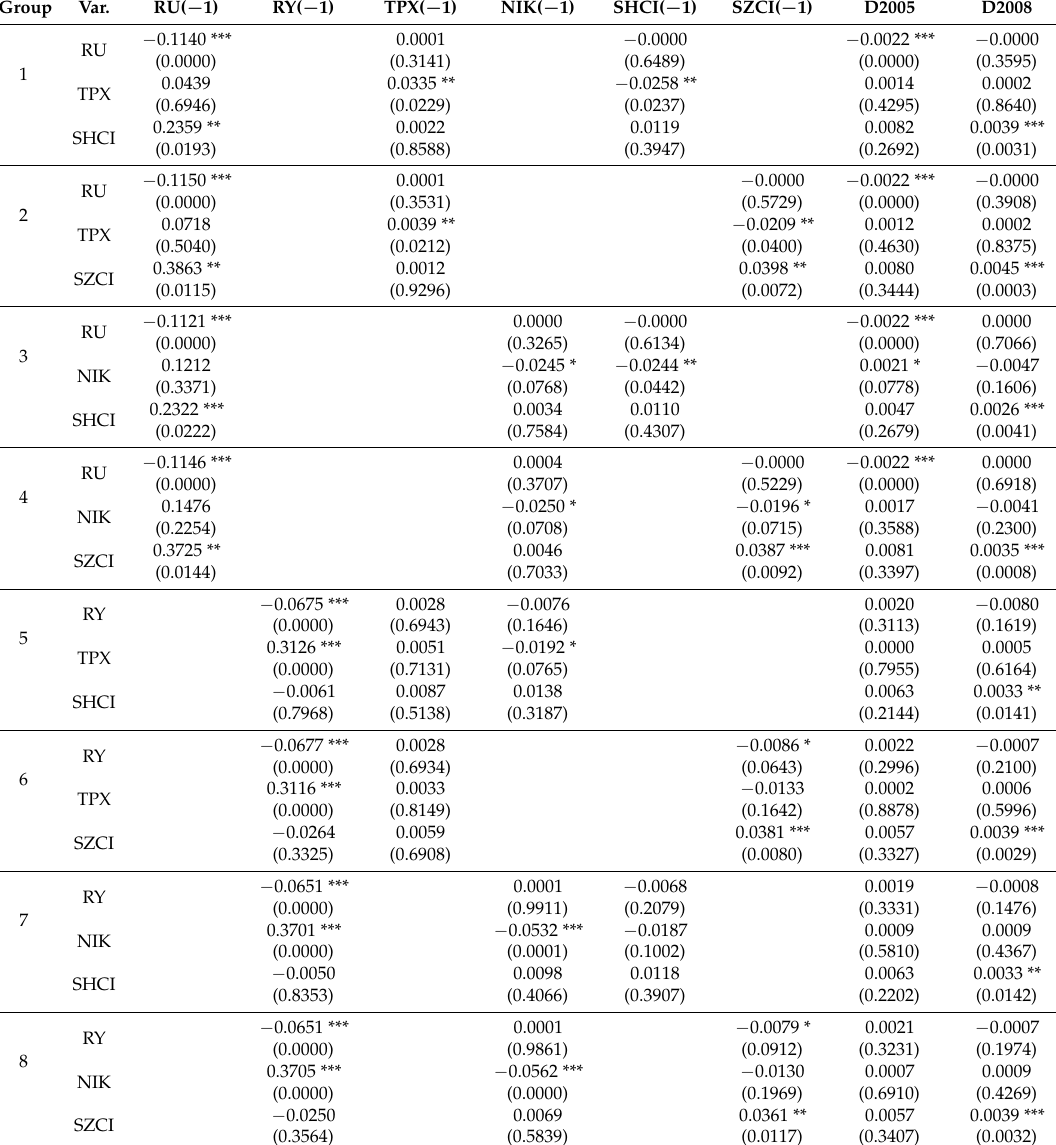
Table 4. Estimation Results of the Mean Equations in the Diagonal BEKK GARCH-M